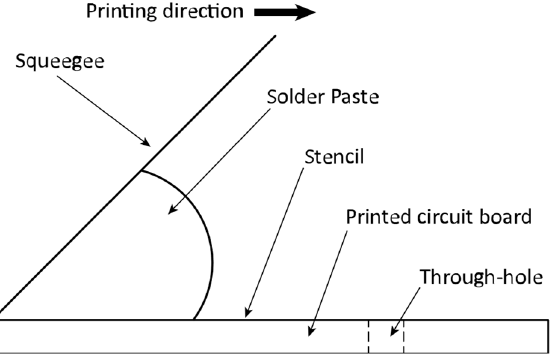
Figure 2. Schematic of the numerical model for analyzing the hole-filling by the solder paste.